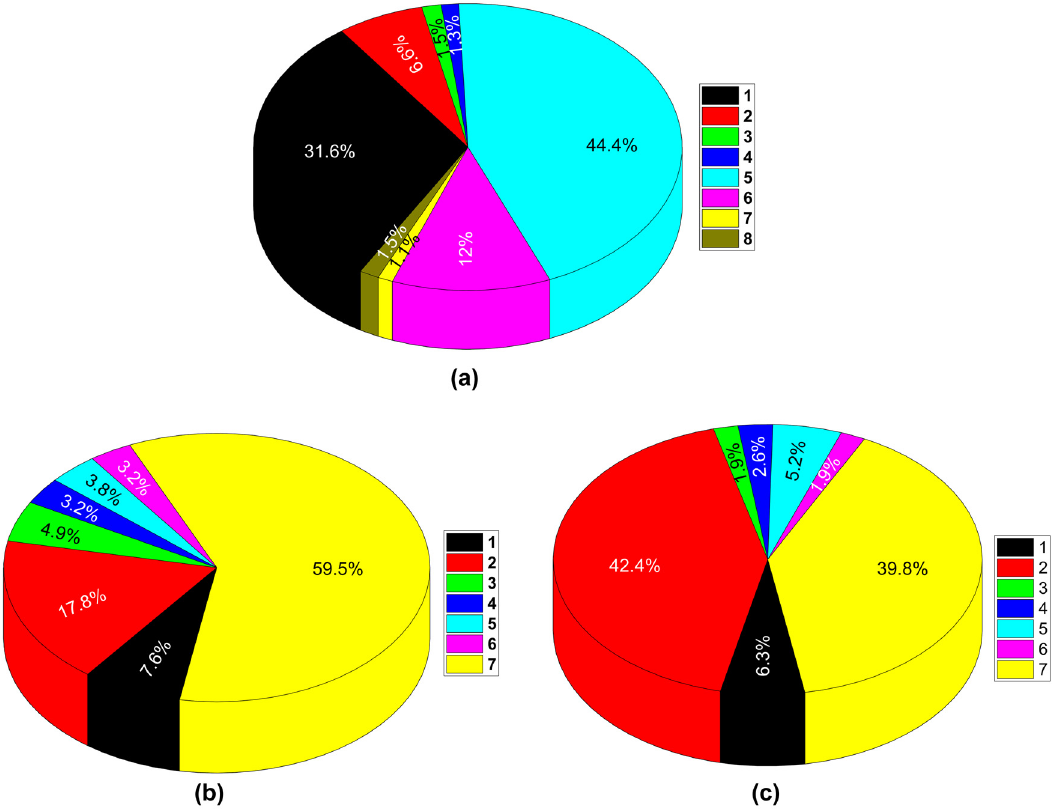
Figure 1: ( a ) Pie chart showing the extent of works reported with di ff erent CNS - based SHPC surfaces: ( 1 ) CNTs, ( 2 ) CNFs, ( 3 ) carbon nano/ microspheres, ( 4 ) carbon nanothorn/onion/others, ( 5 ) GR, ( 6 ) nanoscale carbon soot/graphitic carbon/others, ( 7 ) nanodiamond, and ( 8 ) fullerene. ( b and c ) Pie charts on works reported on ( b ) CNTs and ( c ) GR in di ff erent applications: ( 1 ) anti - corrosion, ( 2 ) oil separation, ( 3 ) anti - icing, ( 4 ) biomedical/anti - biofouling, ( 5 ) sensor, ( 6 ) others, and ( 7 ) fabrication/mechanism ( no speci fi c application studies ) . Both single and multi - component ( with metals/ceramics/polymers ) SHPC surfaces considered. Works reported on SOPC and SAPC systems are also included ( Source: SciFinder/Various sources )